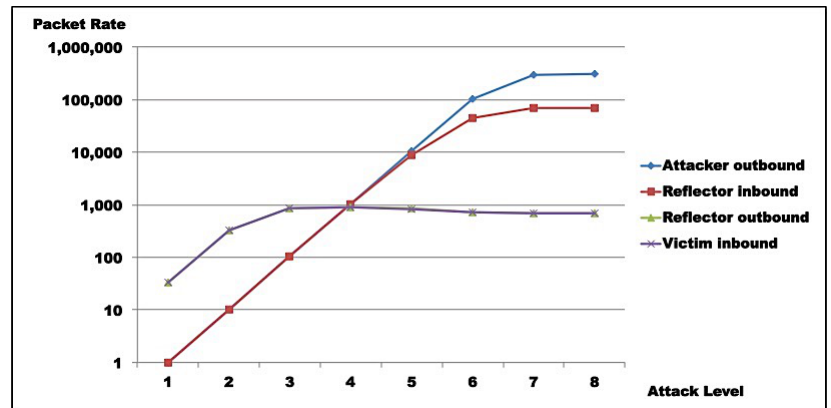
Figure 14. Test 2: Traffic rates